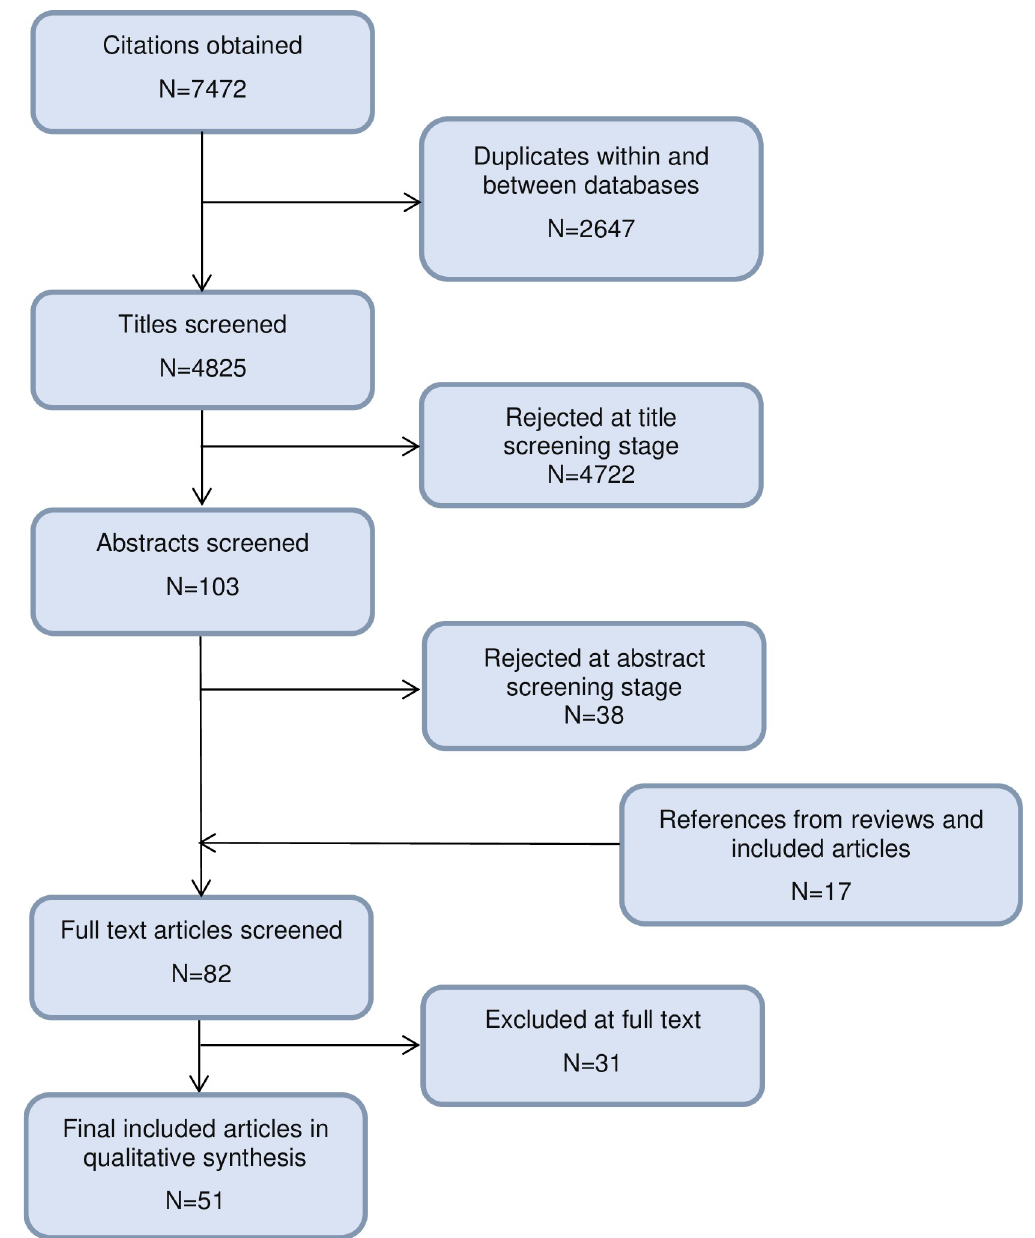
Fig 1. Flowchart of study